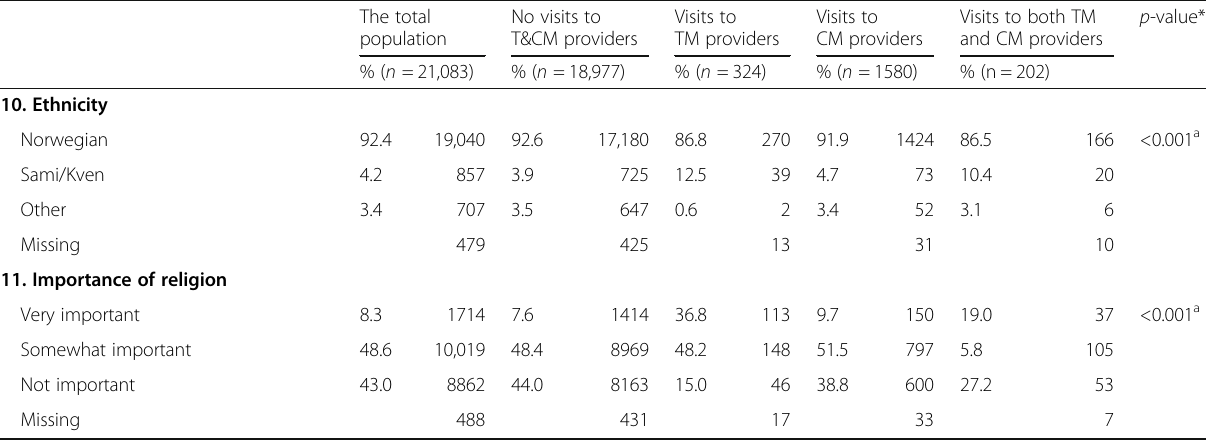
Table 1 Basic characteristics of the total sample and of the participants visiting TM providers, CM providers, and TM as well as CM providers (Continued)